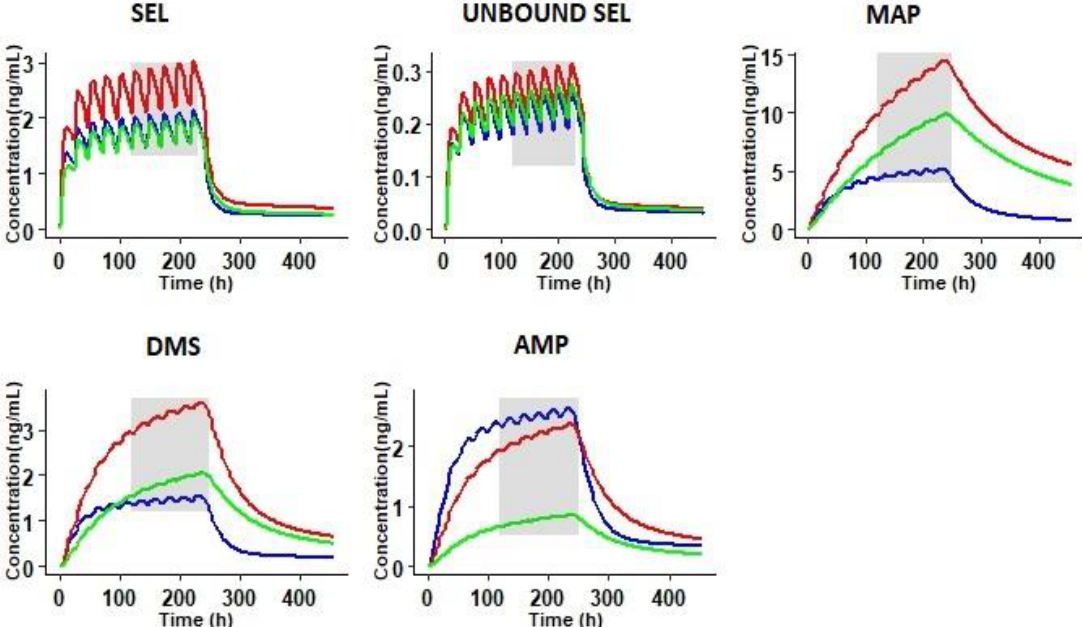
Figure 8. Steady state simulations at a repeated dose of 20 mg / 20 cm 2 / 24 h for 10 days in healthy (blue line), severe renally impaired (red line), and severe hepatic Child Pugh-C subjects (green line). The shaded area represents the steady state concentrations. Table 4. The area under the curve (AUC) and accumulation ratios (AR) of SEL and its metabolites in healthy, severe renally impaired (SRI), and Child-Pugh-C hepatic cirrhosis (CP-C) subjects upon once